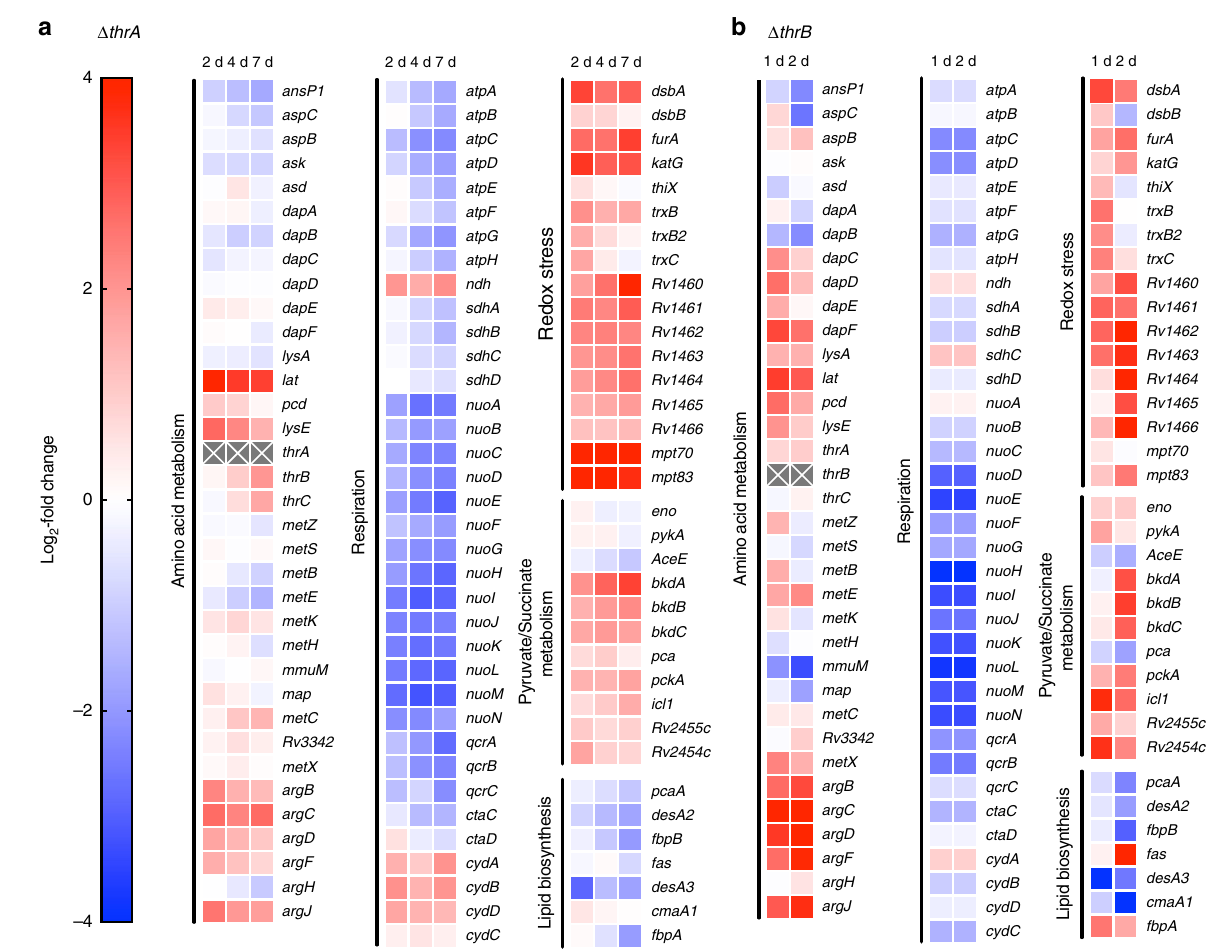
Fig. 2 Time-course transcriptome of Mtb Δ thrA and Δ thrB mutants. Time-course transcriptomic pro fi le of the Δ thrA ( a ) and Δ thrB ( b ) mutants during homoserine and threonine starvation, respectively. Samples from n = 4 ( Δ thrA) and n = 3 ( Δ thrB) biologically independent replicates were harvested on days 0, 2, 4, and 7 for Δ thrA and days 0, 1, and 2 for Δ thrB , and RNA was extracted. Scale is represented in log 2 -fold change compared to day 0 in supplemented media. Genes in relevant pathways are presented. Gene expression ratios were considered statistically signi fi cant if there was a p -value less than 0.05. p -values for each gene and timepoint can be accessed via the GEO database (accession no. GSE119105, GSE119106,